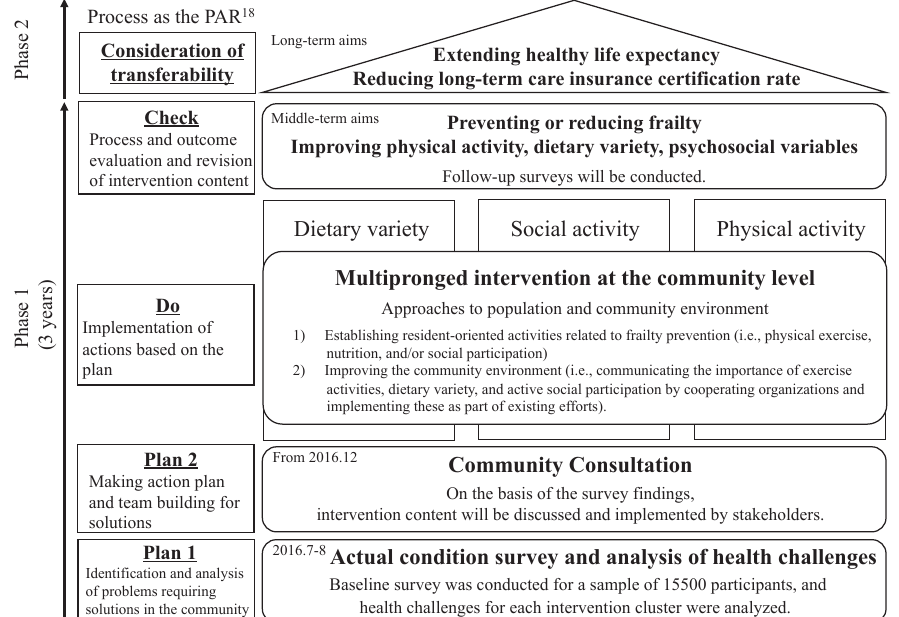
Figure 2. Research roadmap of the Ota Genki Senior Project. PAR, participatory action